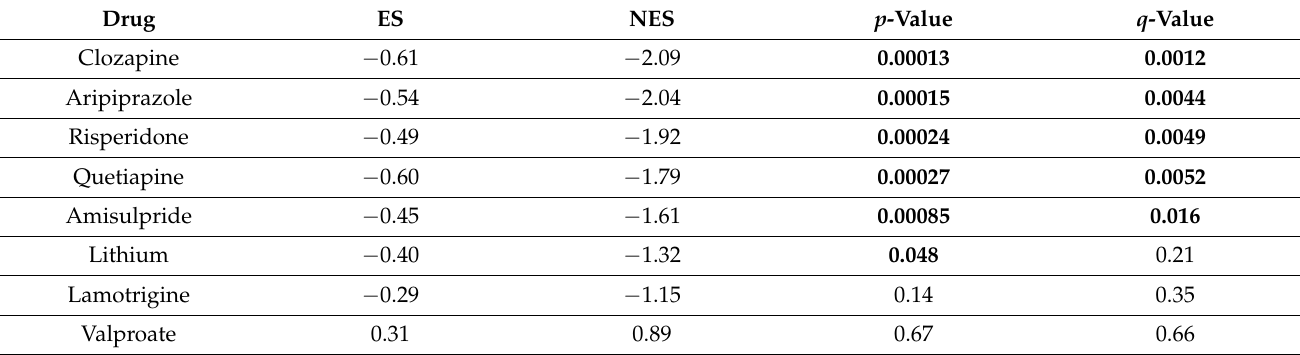
Table 1. Effects of psychoactive drugs on KEGG Hippo pathway gene